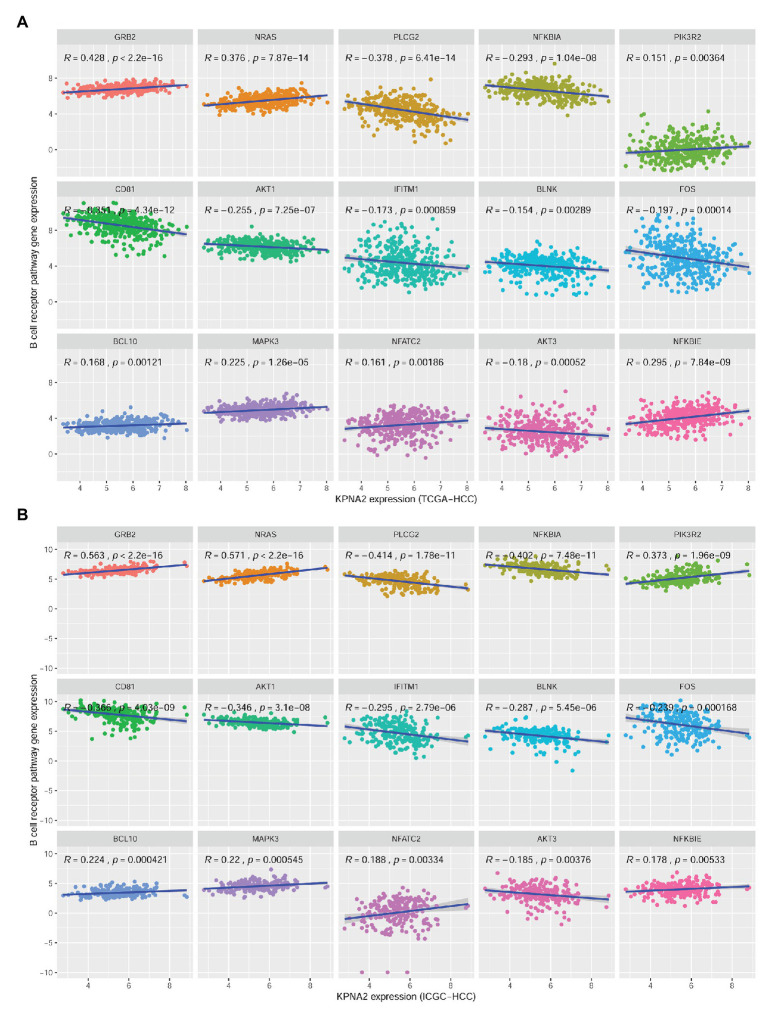
Significant correlations between BCR signaling pathway gene expressions and KPNA2 expression in HCC. (A) Significant positive correlations of GRB2, NRAS, NFKBIE, MAPK3, BCL10, NFATC2, and PIK3R2 and negative correlations of BLNK, IFITM1, AKT3, FOS, AKT1, NFKBIA, CD81, and PLCG2 with KPNA2 expression in HCC in the TCGA-HCC dataset. (B) Significant positive correlations of GRB2, NRAS, NFKBIE, MAPK3, BCL10, NFATC2, and PIK3R2 and negative correlations of BLNK, IFITM1, AKT3, FOS, AKT1, NFKBIA, CD81, and PLCG2 with KPNA2 expression in HCC in the ICGC-HCC dataset. The x-axis and y-axis represented the relative expression of KPNA2 and BCR signaling pathway genes, respectively. The gene expressions were CPM normalized and log2(x + 0.001) transformed. BCR, B-cell receptor; R, correlation coefficient; CPM, count per million. Spearman correlation was used, and |R| ≥ 0.15 with p < 0.01 was considered significant.